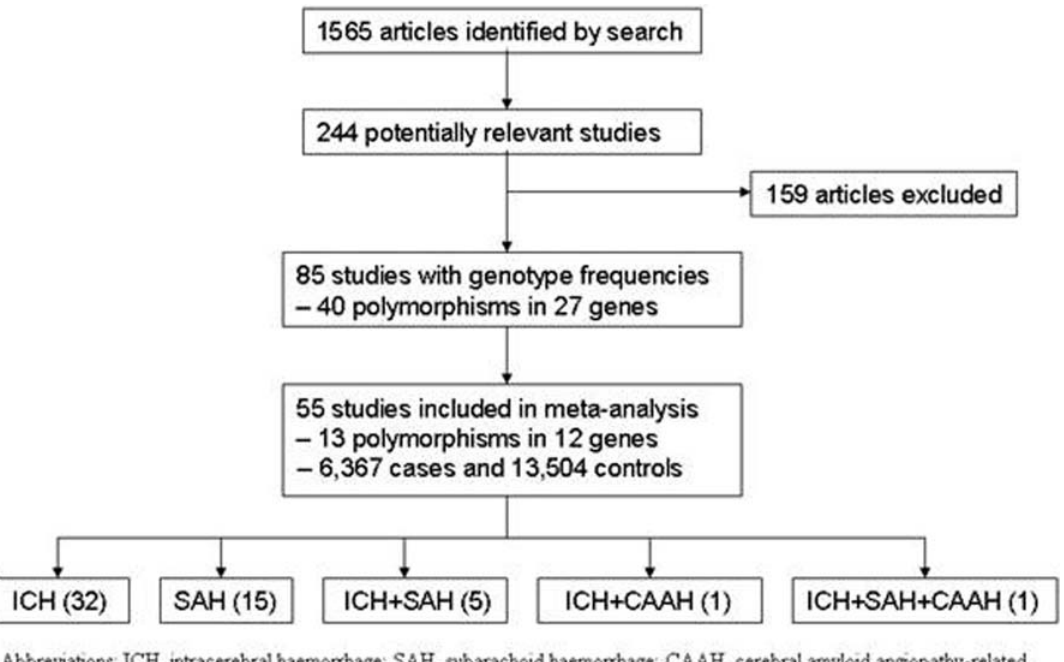
Figure 1. Flow chart illustrating number of studies included in the meta-analyses.